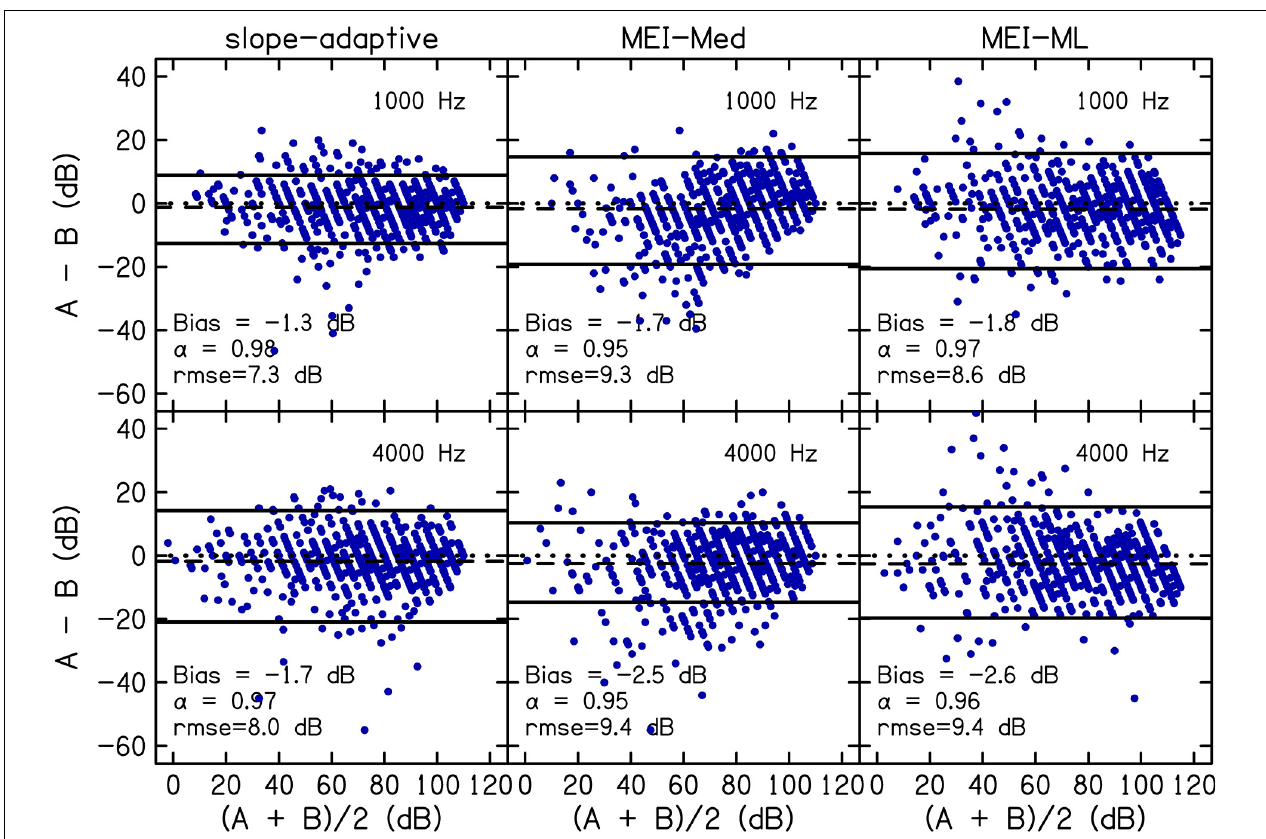
FIGURE 6 | Accuracy was assessed by comparing slope-adaptive and MEI-adaptive procedures to the fixed-level procedure. Panels are Bland-Altman plots for each CLS procedure at 1 (top row) and 4 kHz (bottom row). A = fixed-level procedure; B = adaptive procedure. Data points represent the difference between the